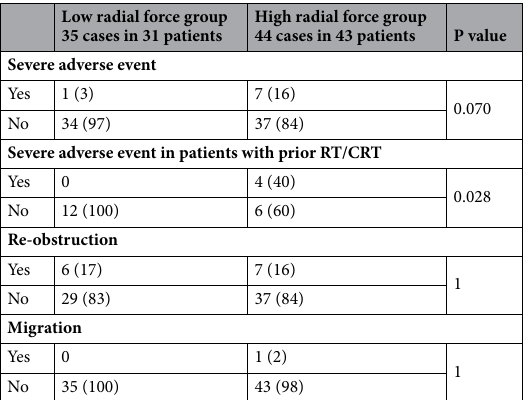
Table 5. Outcome of patients with squamous cell carcinoma. Data are presented as n (%). These data were compared using Fisher’s exact test.